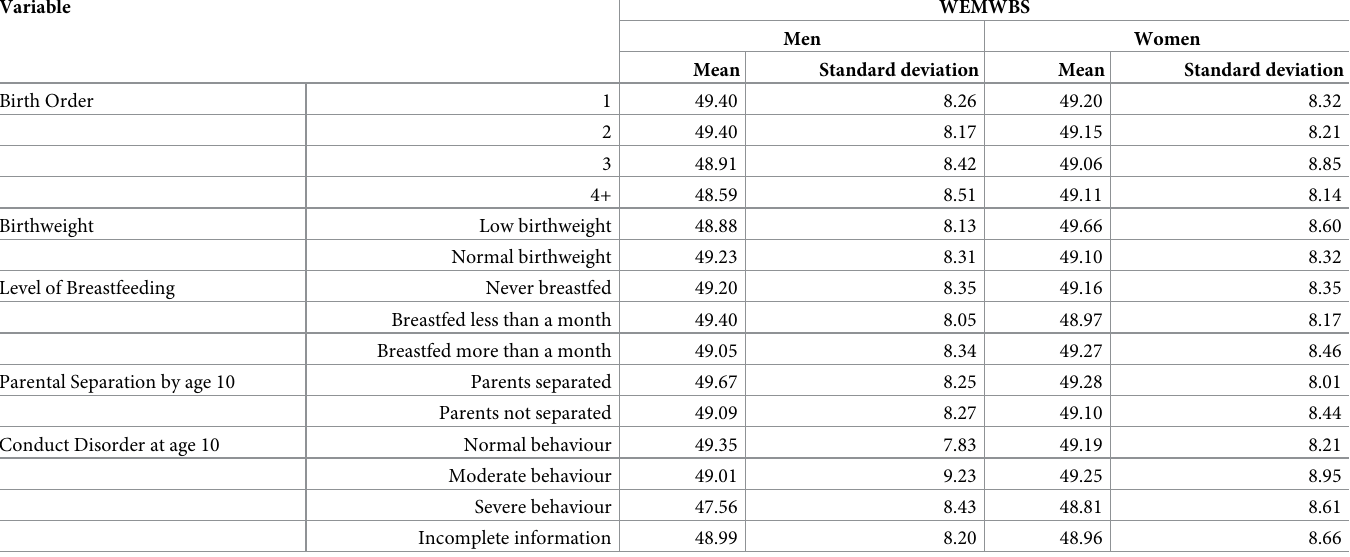
Table 2. Mean and Standard Deviation of WEMWBS: Bivariate associations with birth order, and childhood mediators.